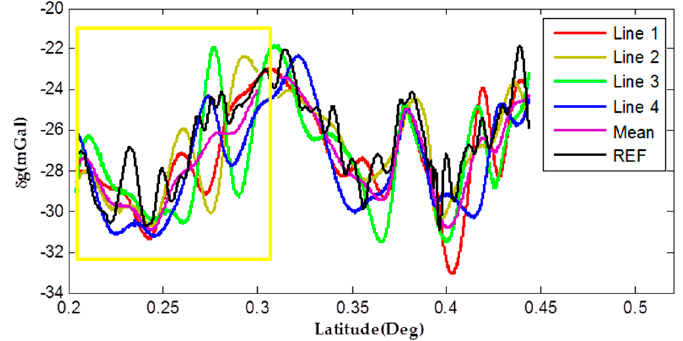
Figure 8. Former gravity disturbances using SINS/GNSS method.